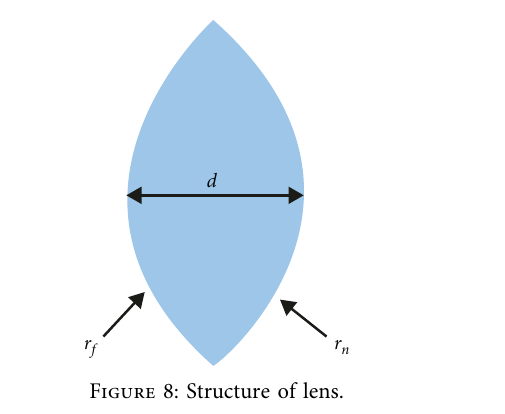
Figure 6: Antenna prototype: (a) front; (b) back.